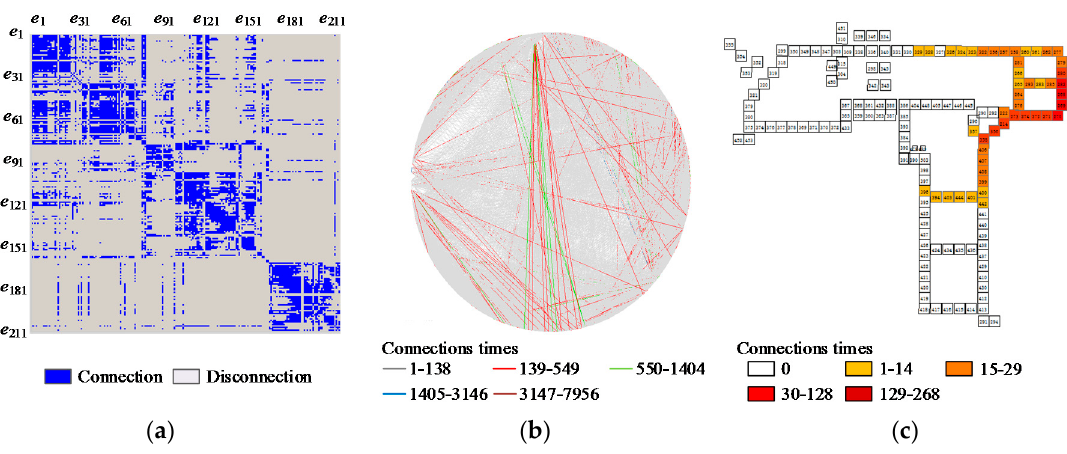
Figure 9. The start and end node analysis. ( a ) The matrix representation; ( b ) The circular representation; ( c ) End nodes for start sensor 272.